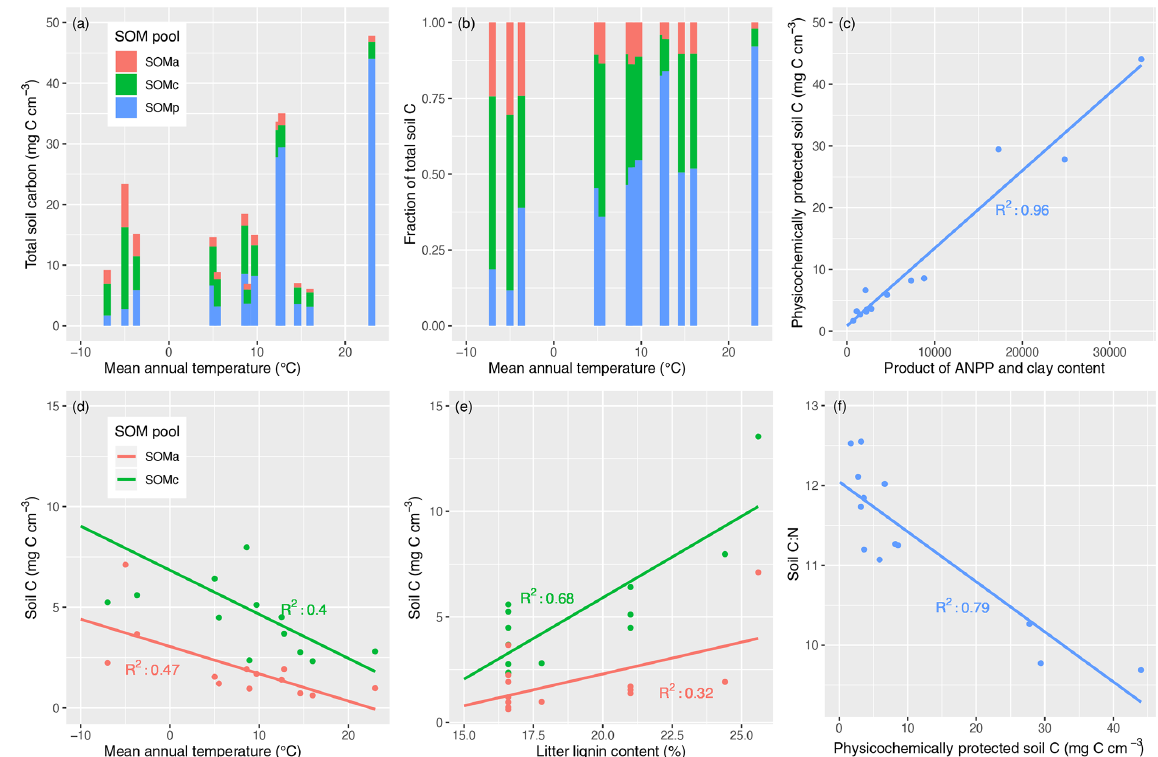
Figure 6. Variation in steady-state SOM pools and environmental factors controlling their distribution in MIMICS-CN simulations across LIDET sites. Top panels show the (a) total C stocks in physicochemically protected, chemically protected, and available SOM pools (SOM p , SOM c , SOM a pools, respectively) arranged by the site mean annual temperature (MAT) or the (b) relative fraction of each SOM pool arranged in the same way. Upper-right and bottom panels show the correlations between C in each SOM pool and environmental drivers including: (c) SOM p vs. the product of annual net primary productivity (ANPP) and clay content, (d) SOM c and SOM a vs. MAT, and (e) SOM c and SOM a vs. lignin content of litter inputs at each site. Finally, (f) soil stoichiometry is largely determined by the fraction of total SOM pools that are considered physicochemically